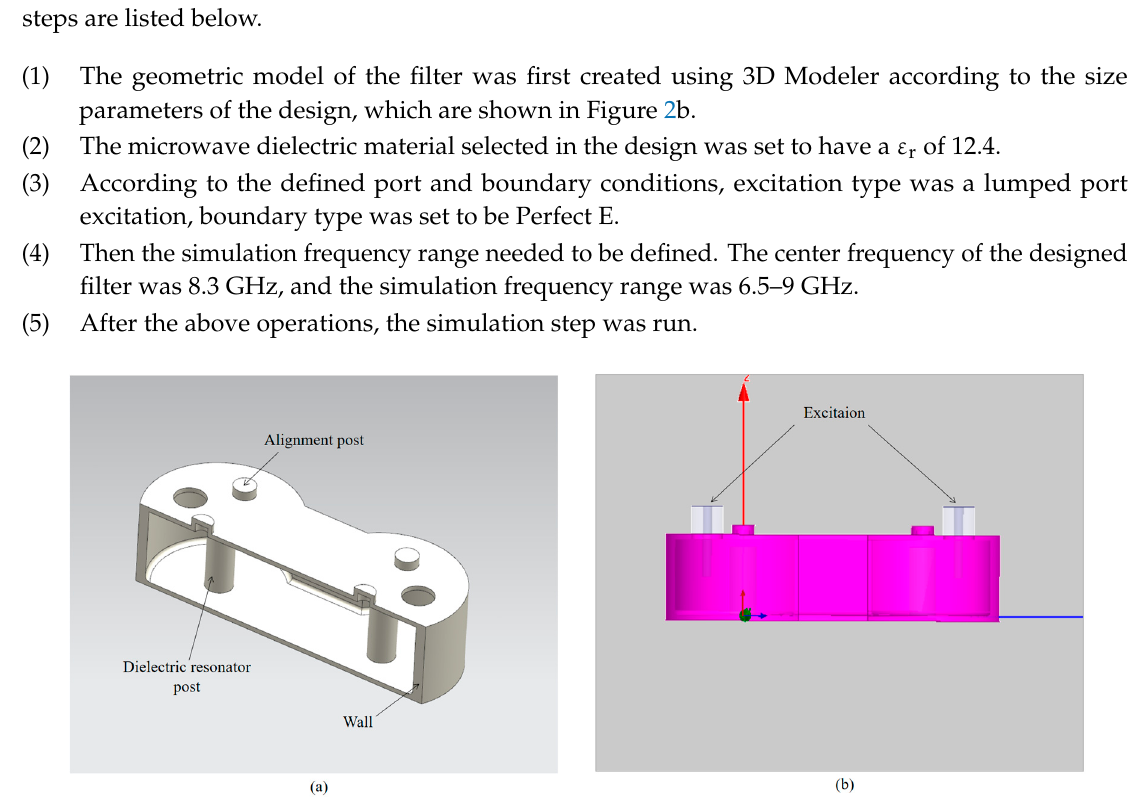
Figure 2. Prototype of the designed microwave dielectric ceramic filter. ( a ) Structure geometry and ( b ) simulation layout.